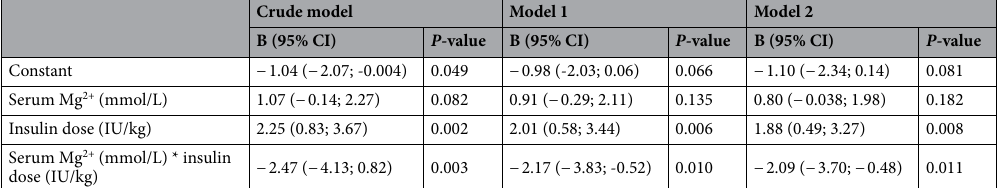
Table 3. Interaction effect of the moderator insulin dose and serum Mg 2+ associated with Log 10 hs-CRP. Model 1 is age- and sex adjusted. Model 2 is adjusted for duration of diabetes (years), eGFR (< 60, 60–90, > 60 mL/min/1.73m 2 ), alcohol use (yes/no), smoking (current, former, never), SBP (mmHg), TG (mmol/L), LDL cholesterol (mmol/L), statins (yes/no) and PPI (yes/no) drugs. eGFR = estimated glomerular filtration rate, LDL = low-density lipoprotein, Mg 2+ = magnesium, PPI = proton pump inhibitor, SBP = systolic blood pressure, TG =